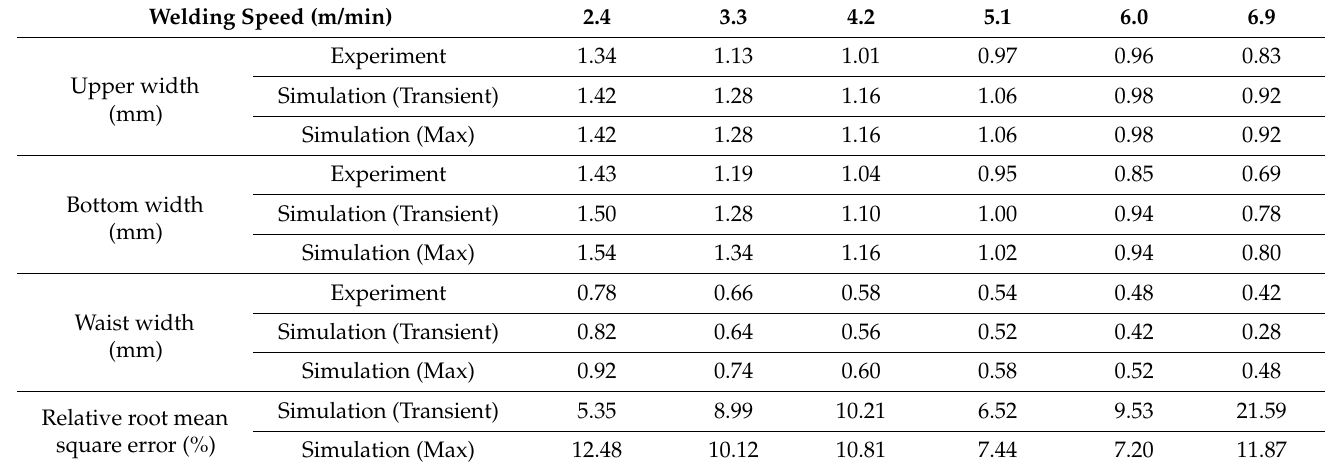
Table 1. Predicted upper/bottom/waist widths of the two WCSs using different welding speeds.